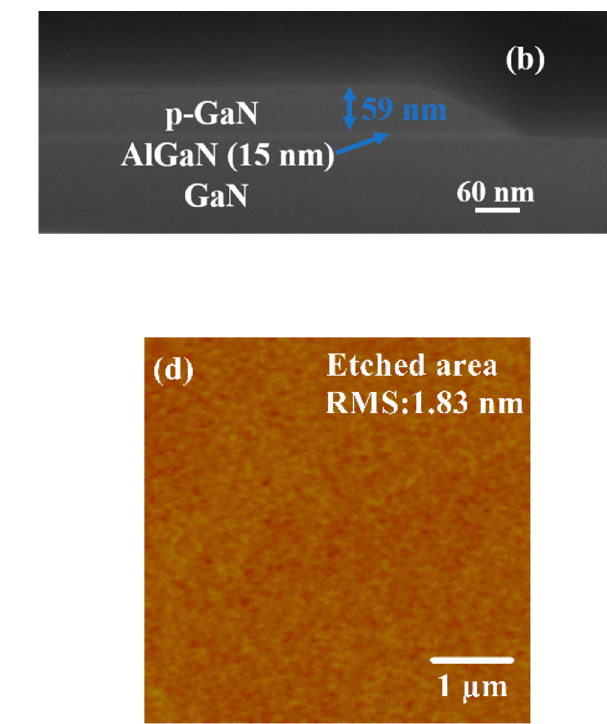
Figure 6. ( a ) Cross-sectional structure of the p-GaN HEMT device, ( b ) cross-section focused ion beam (FIB) image of the p-GaN HEMT after complete p-GaN removal from access regions, ( c ) surface morphology of the p-GaN HEMT non-etched area, ( d ) surface morphology of the p-GaN HEMT etched area.